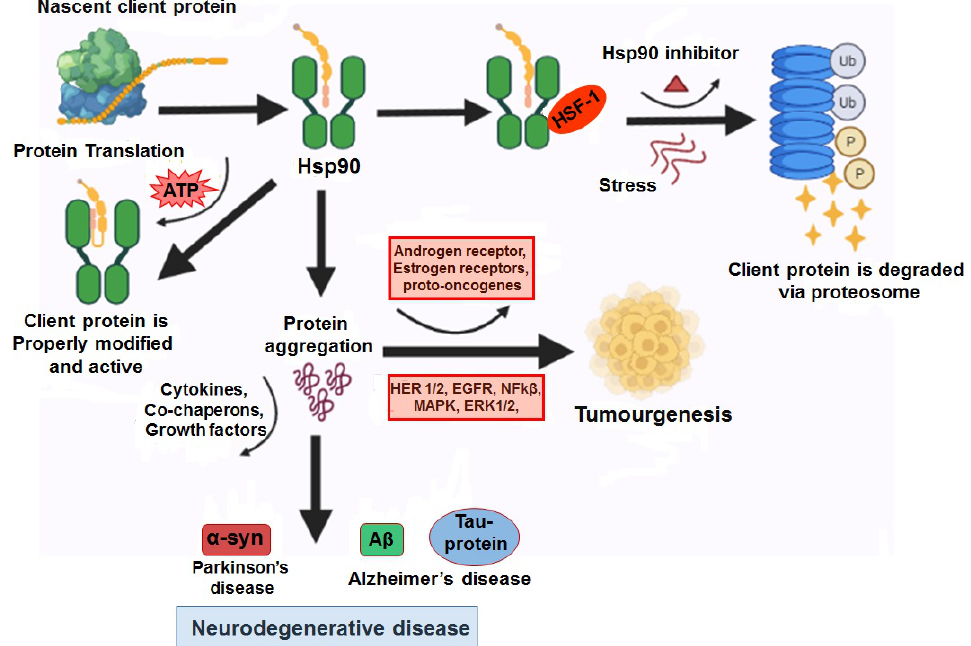
Figure 5. Representations depicting the role of Hsp90 and associated co-chaperons in cancer and neurodegenerative diseases. neurodegenerative